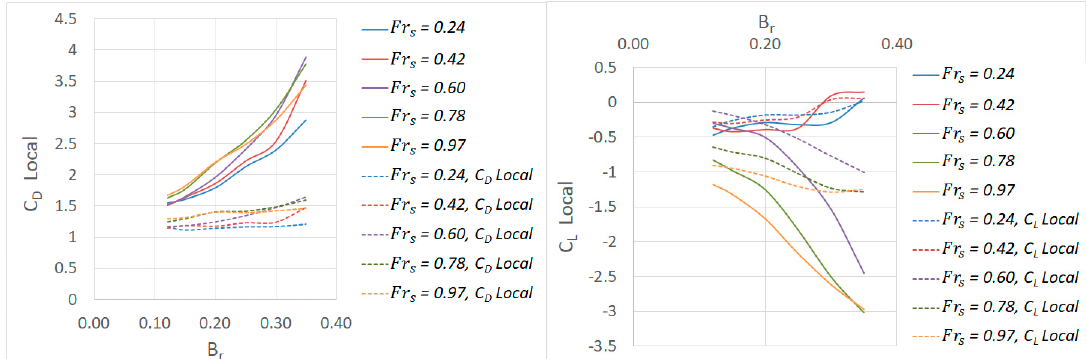
Figure 22. Drag coefficient ( left ) and lift coefficient ( right ) versus the blockage ratio. Based on the two scenarios of undisturbed upstream velocity and local velocity (dotted lines). h* = 2.